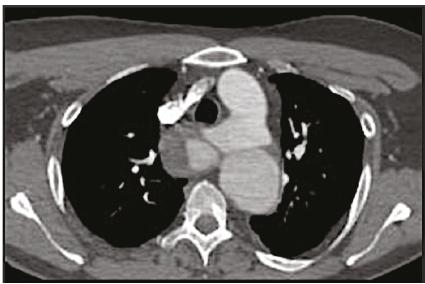
Figure 1: Preoperative chest CT showing type B aortic dissection from the origin of the left subclavian artery.